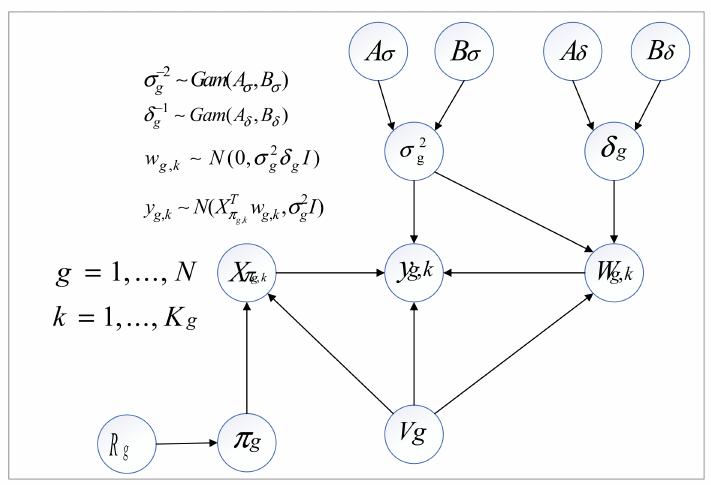
Figure 1. Hierarchy of PCCs-ED-DBN.